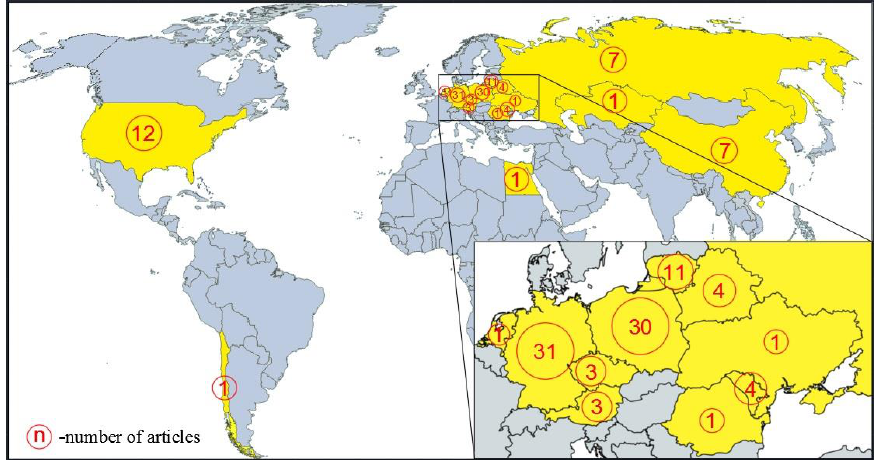
Figure 2. Map of published Silphium perfoliatum –related scientific articles, by country, in